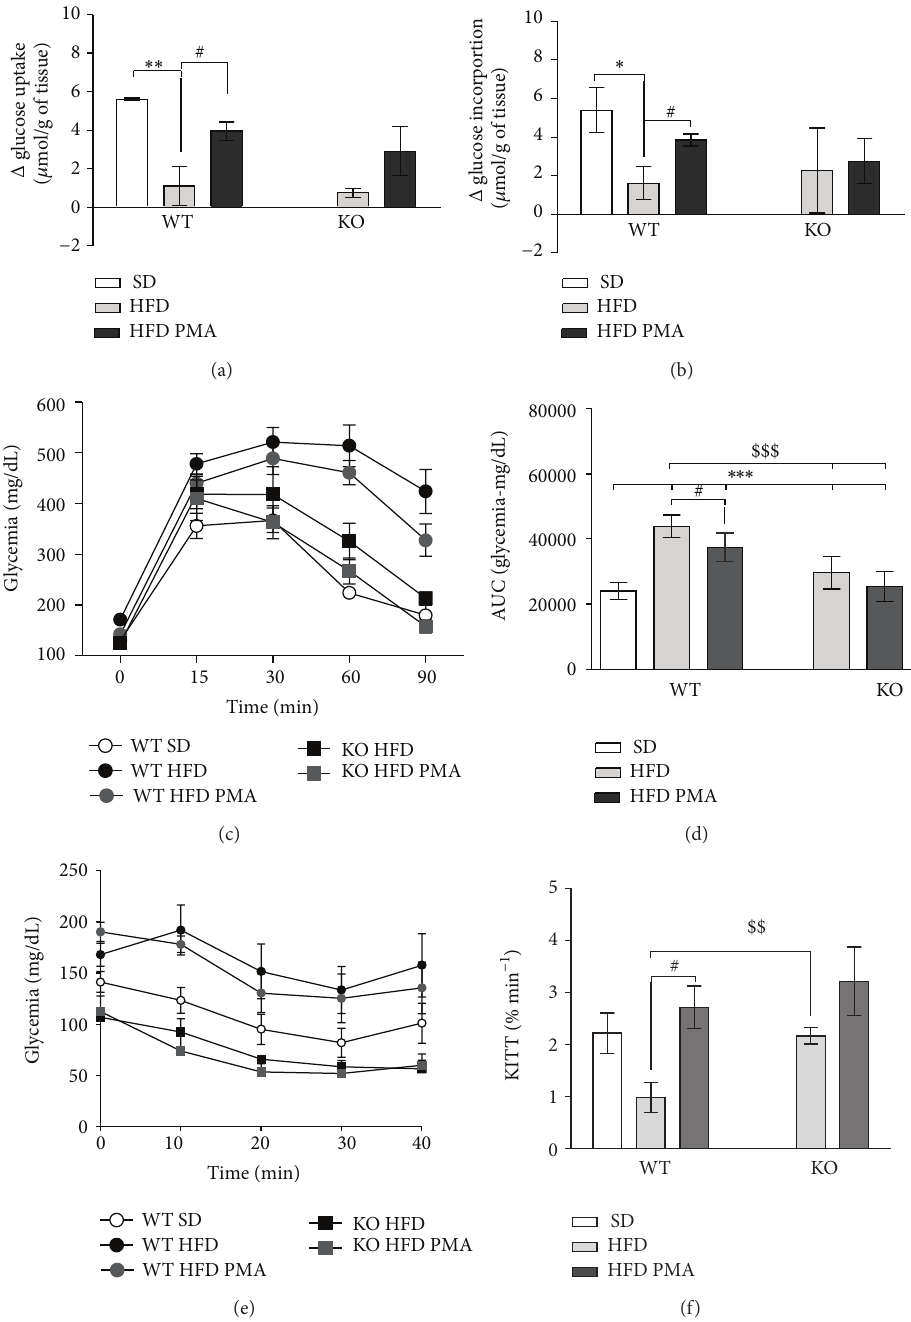
Figure 1: Delta ( Δ ) of glucose uptake (a) and incorporation (b), variation in glycemia in the glucose tolerance test (c), and respective area under curve (AUC) (d). Variation in glycemia in the insulin tolerance test (e). Respective constants for glucose clearance (f) of WT mice fed with a standard diet (SD) or WT and PPAR 𝛼 -knockout (KO) mice subjected to a high-fat diet and treated with oleic acid (HFD) or palmitoleic acid (HFD PMA). The data are presented as mean ± SEM. ∗ 𝑃 < 0.05 , ∗∗ 𝑃 < 0.01 , and ∗∗∗ 𝑃 < 0.001 versus WT SD; # 𝑃 < 0.05 HFD versus HFD PMA; and $$ 𝑃 < 0.01 and $$$ 𝑃 < 0.001 KO versus the respective WT control (one-way ANOVA followed by Bonferroni correction).